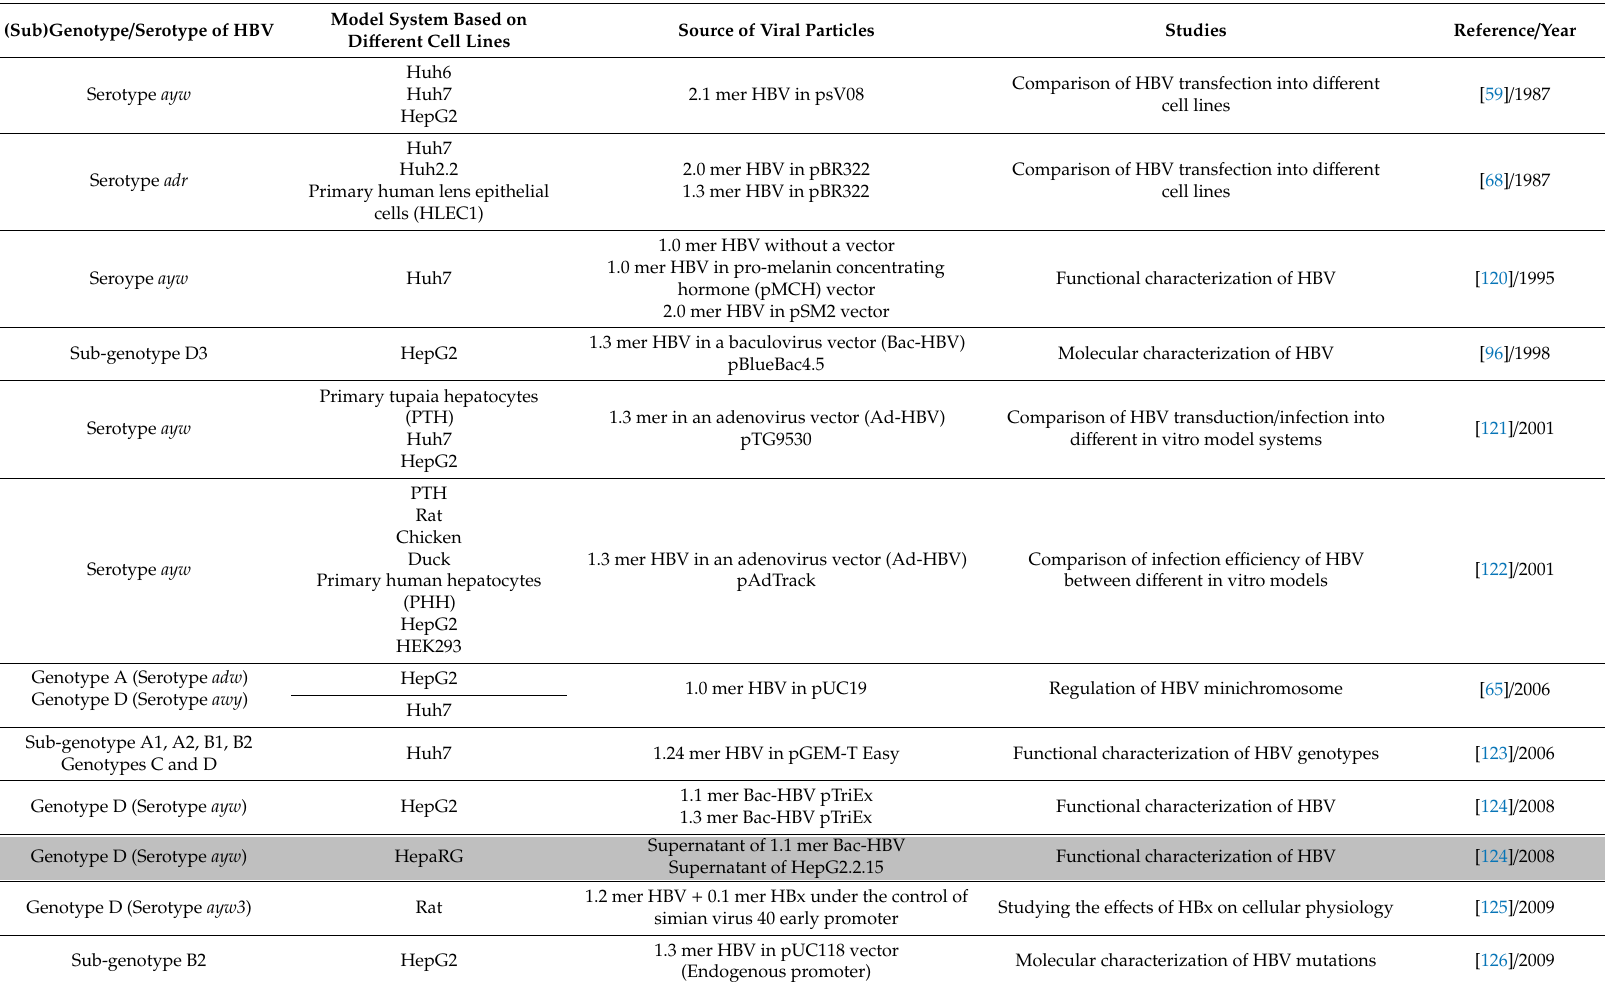
Table 2. Studies conducted for the various genotypes / sub-genotypes of hepatitis B virus (HBV) in di ff erent in vitro model